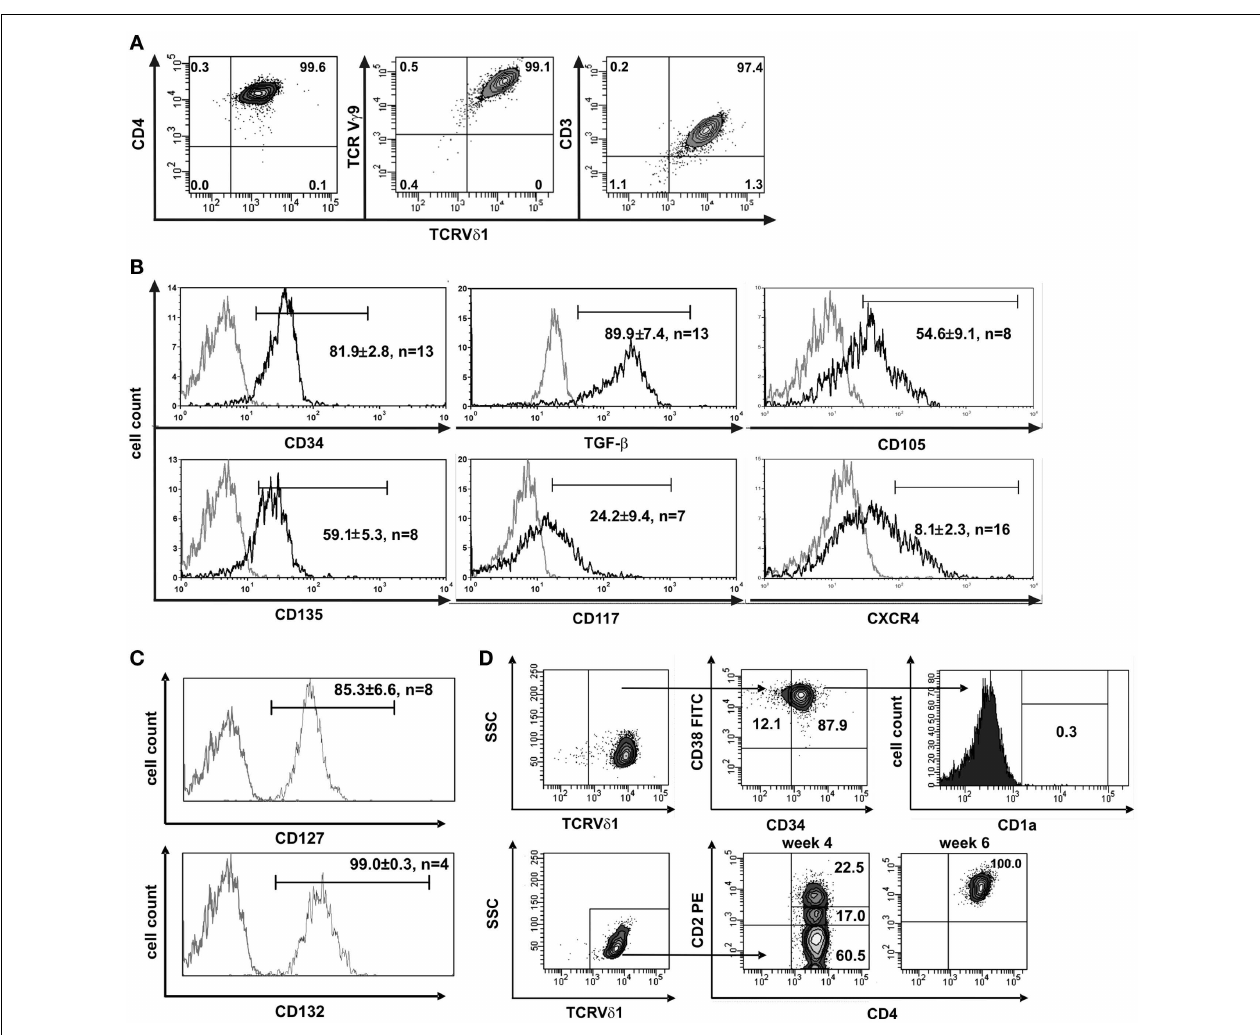
that stained positive for the respective marker (given in %). Each histogram shows one representative experiment of all clones tested. Numbers of clones tested are given in each histogram. (C) V δ 1 + CD4 + T-cell clones express IL-7 receptor composed of α subunit CD127 and the common γ chain CD132 of IL-2R. (D) FACS analysis showed that CD4 + V δ 1 + T-cell clones are CD34 + CD38 + CD1a neg , may lack CD2 expression, but become CD2 + during